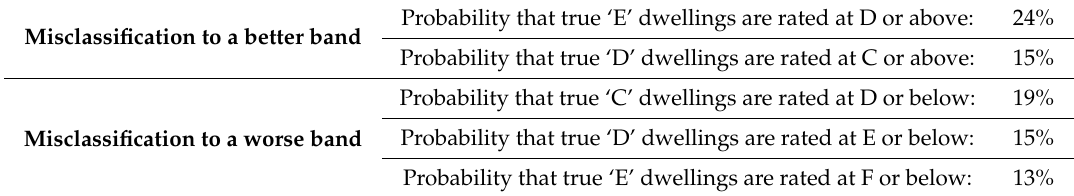
Table 3. Estimated chance of misclassification of